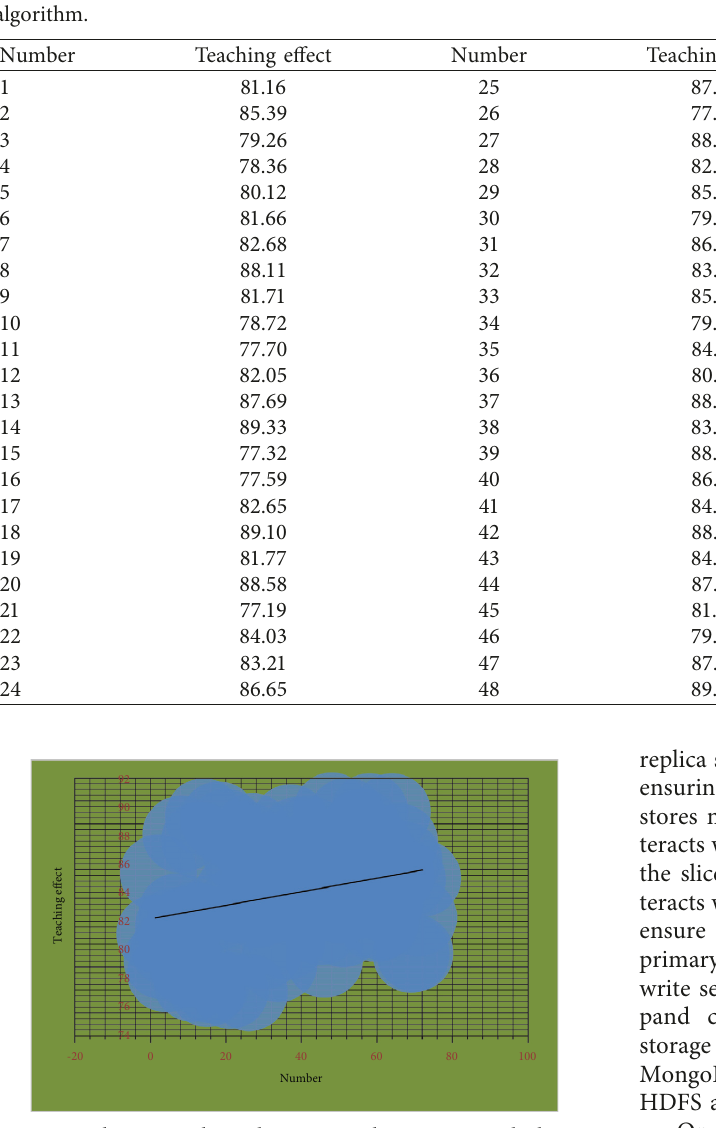
Figure 8: Chinese teaching clustering in the international Chinese education expert system based on artificial intelligence and ma- chine learning